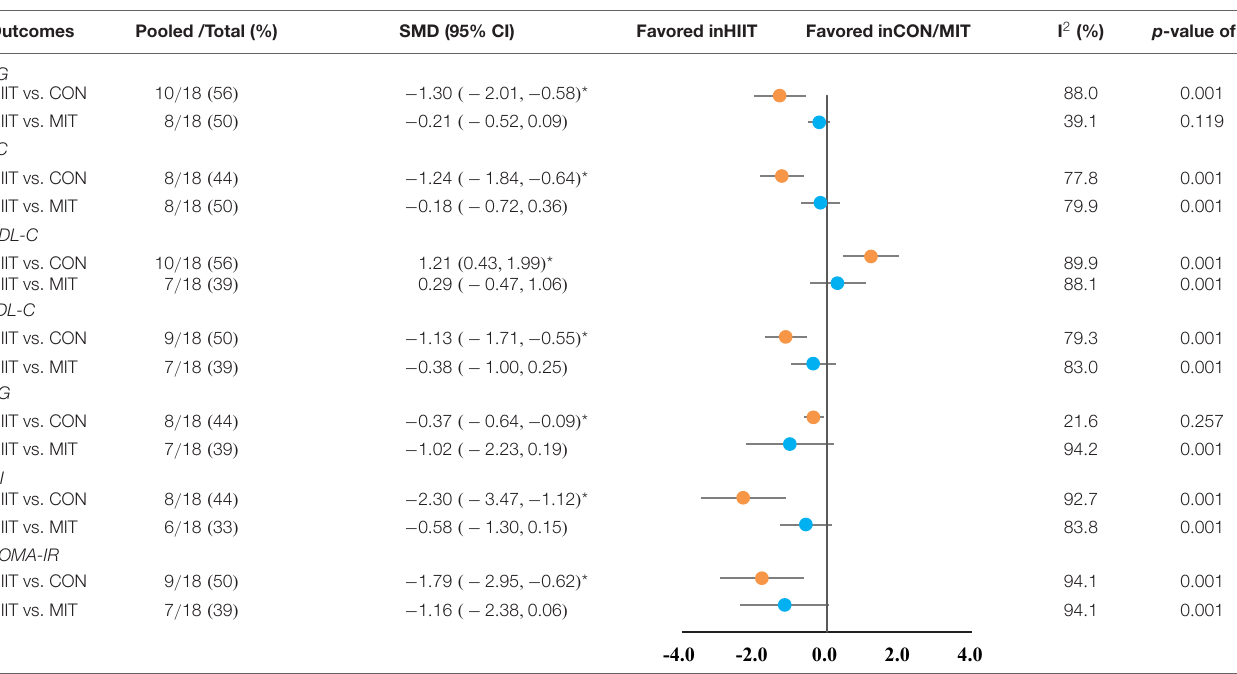
TABLE 3 | Pooled effects of HIIT vs. CON or MIT on glycolipid outcomes.